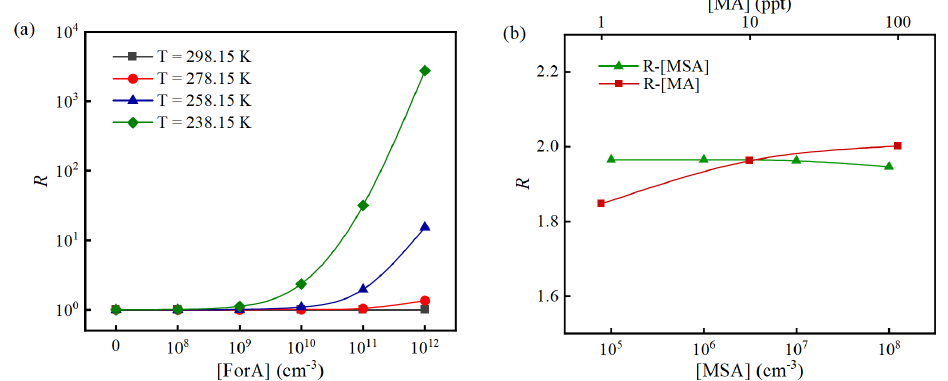
Figure 5. The enhancing coefficient ( R ) as a function of [ForA] at [MA] = 10ppt, [MSA] = 10 7 cm − 3 , and four temperatures (238.15, 258.15, 278.15, and 298.15K) (a) and as a function of [MSA]/[MA] at [MA] = 10ppt/[MSA] = 10 7 cm − 3 , [ForA] = 10 11 cm − 3 , and T = 258 . 15K (b) .